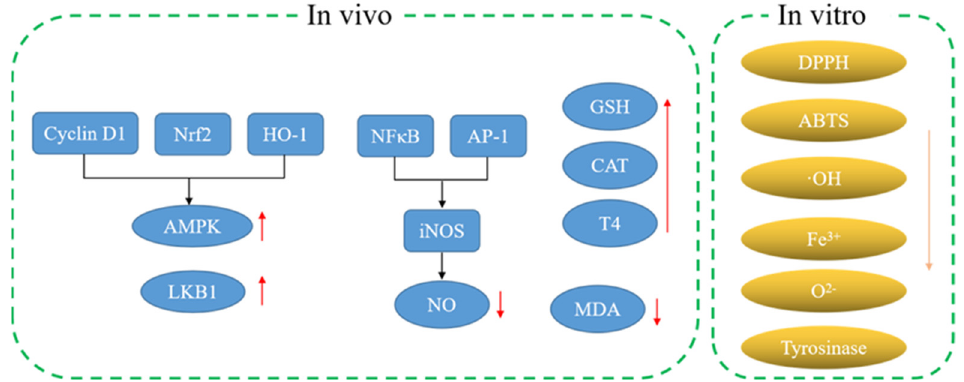
Figure 2. Antioxidant mechanism of